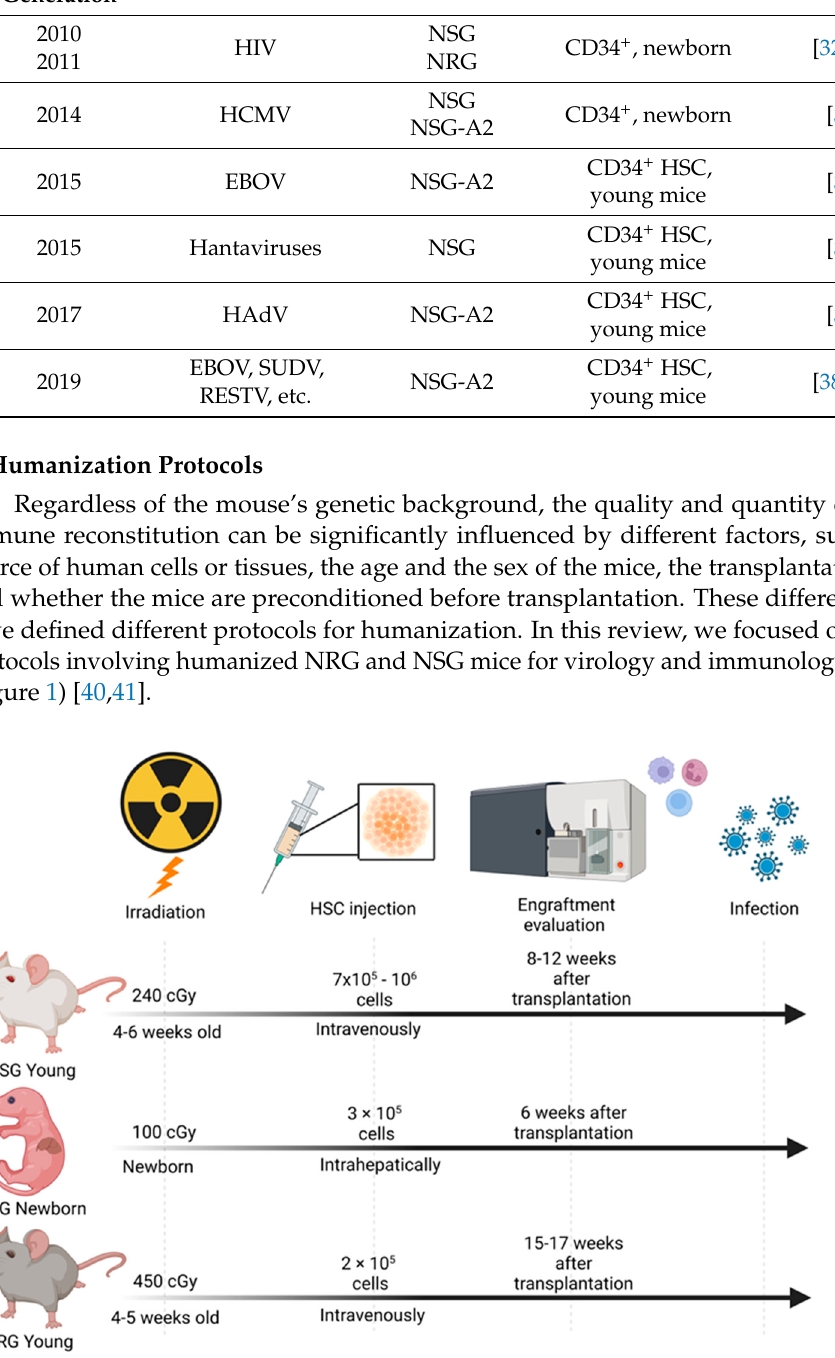
Figure 1. Schematic representation of the different steps to generate humanized NSG and NRG mice for virology and immunology research. Created with BioRender.com.